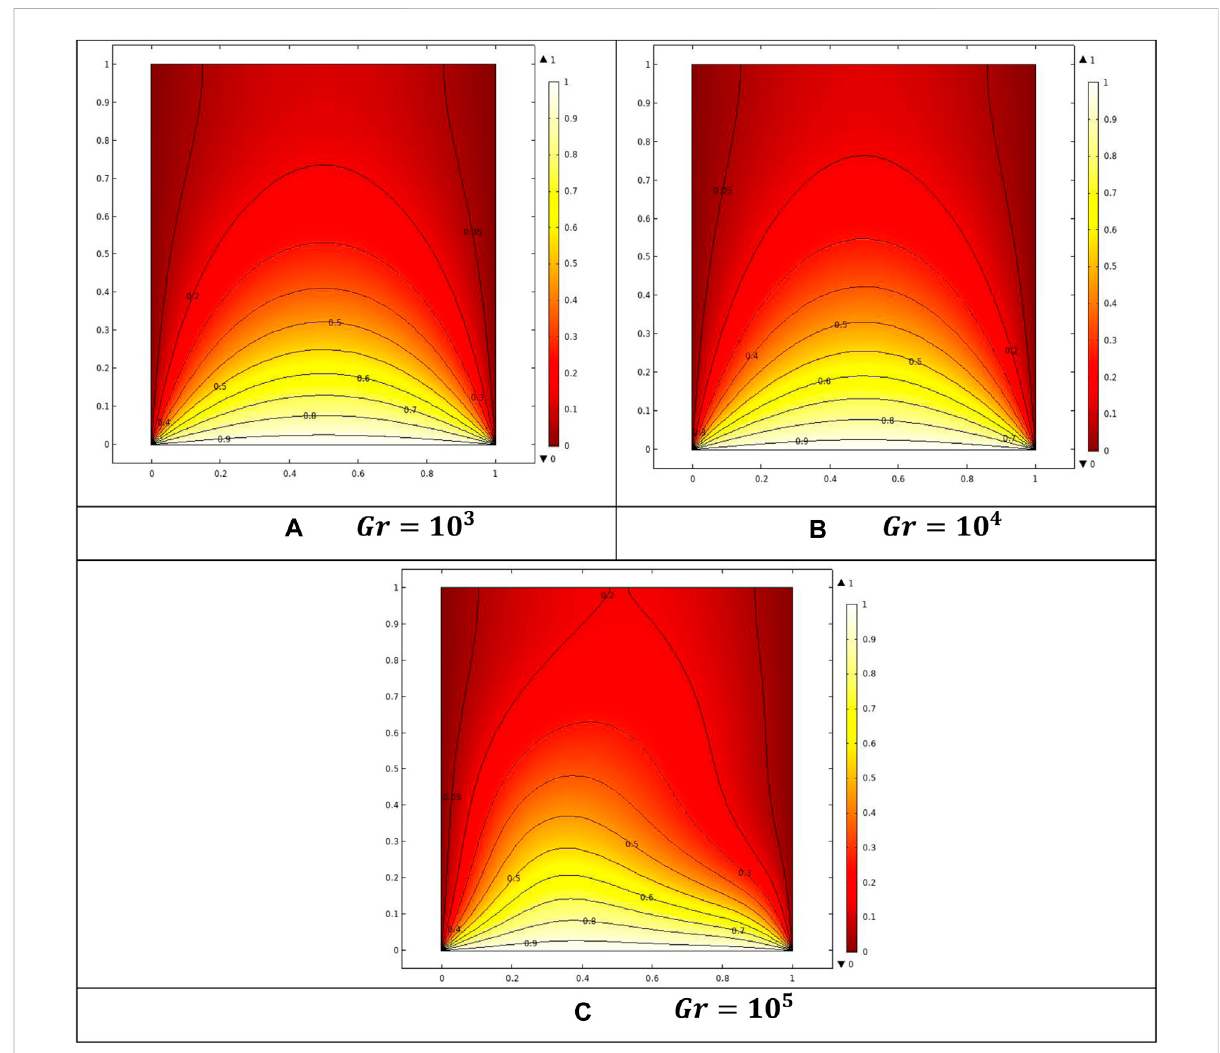
FIGURE 6 In fl uence of Gr on temperature distribution for the uniform heating case: (A) Gr (cid:1) 10 3 , (B) Gr (cid:1) 10 4 , and (C) Gr (cid:1) 10 5 .